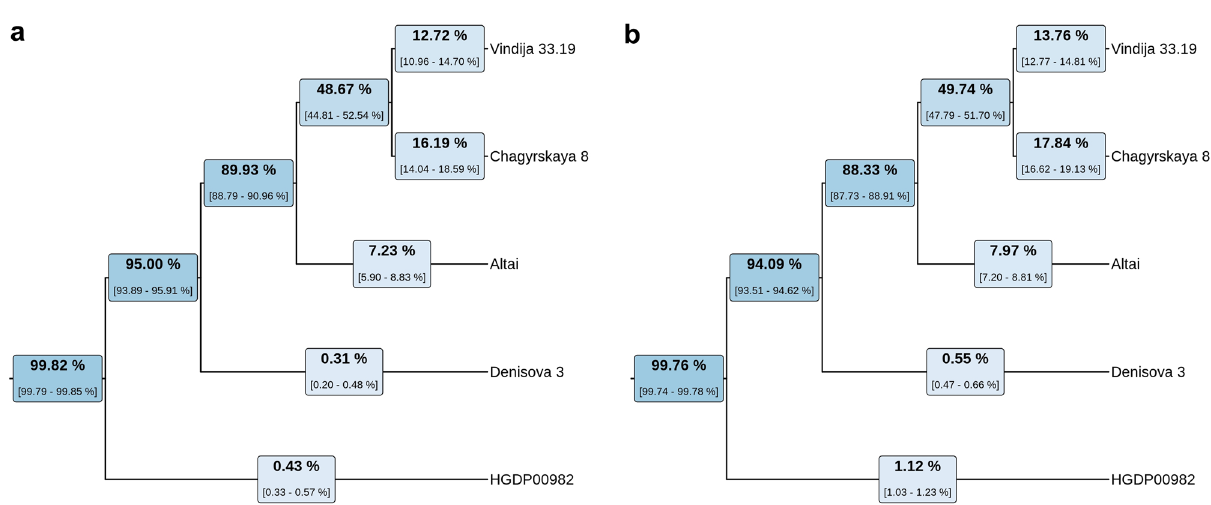
Figure 4. Autosomal derived allele sharing with the three high-coverage Neanderthals ( Vindija 33.19 , Chagirskaya 8 , Altai ), Denisova 3 and present-day human (HGDP00982, Mbuti) for putatively deaminated ( a ) and total ( b ) Mezmaiskaya 3 sequences (length ≥ 35, MAPQ ≥ 25). The 95% binomial confidence intervals are indicated in